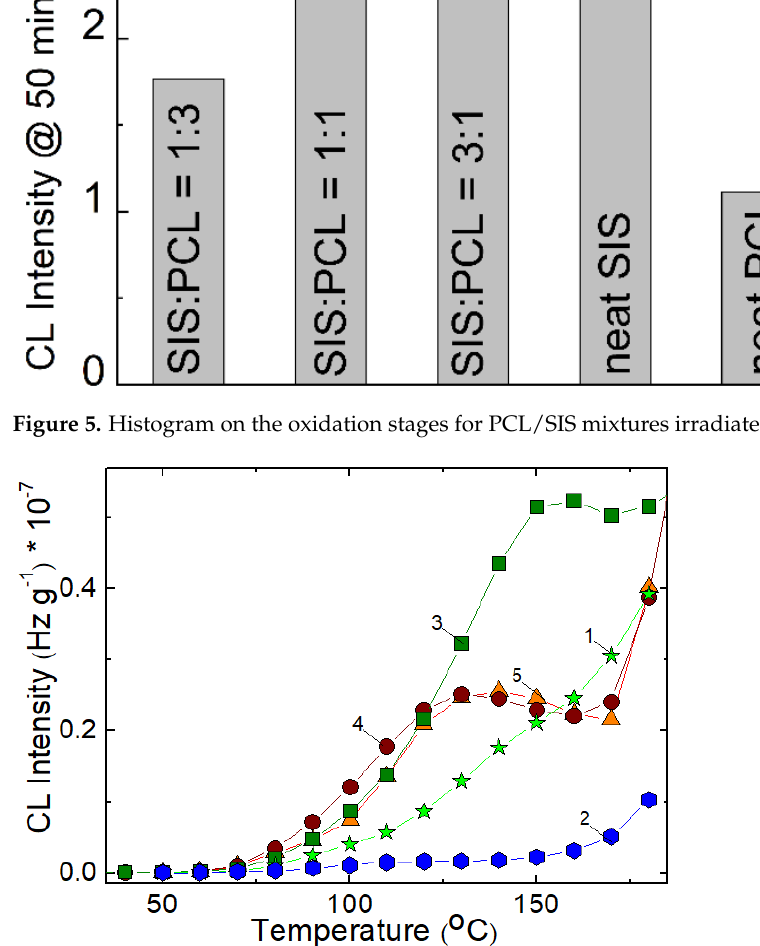
( b ) ( c ) Figure 7. Isothermal CL spectra recorded on PCL:SIS samples after their irradiation at 100 kGy. Temperatures: (1) 130 °C; (2) 140 °C; (3) 150 °C; ( a ) PCL:SIS = 3:1; ( b ) PCL:SIS = 1:1; ( c ) PCL:SIS = 1:3.